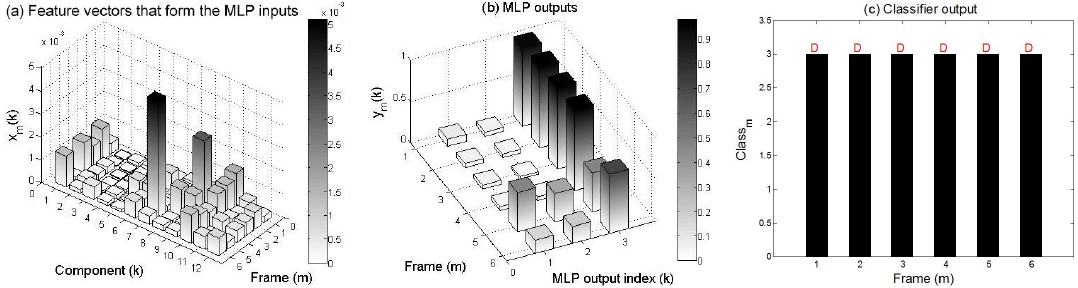
Figure 14. ( a ) feature vectors based on STFT extracted from a D call; ( b ) MLP outputs; and ( c ) class recognizer output. Over all frames, the D call is discriminated from the A and B